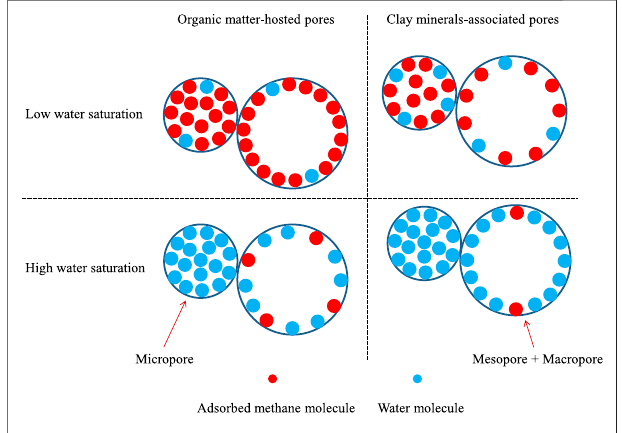
FIGURE 5 | Adsorption mode of methane in pore systems at different water saturation